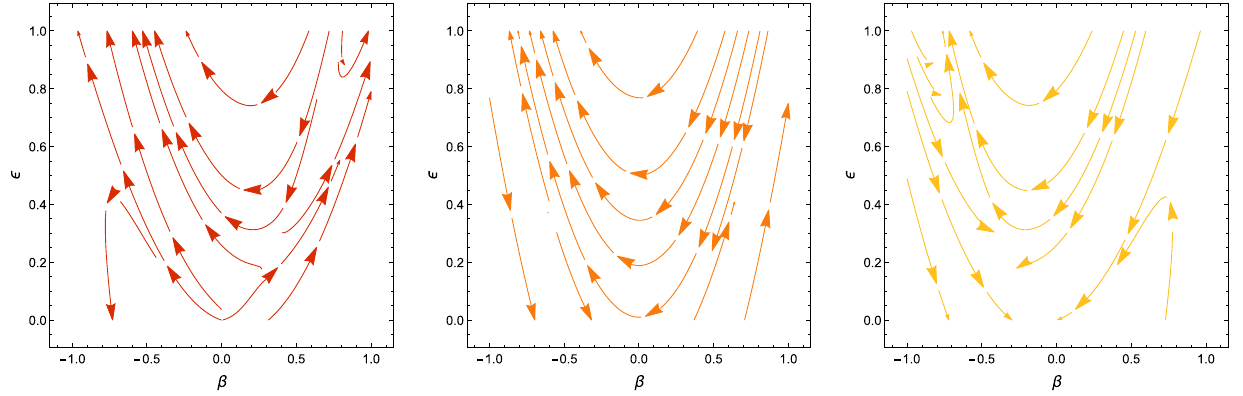
(cid:5) (cid:3) (cid:4) ω ,ω = , m g 3